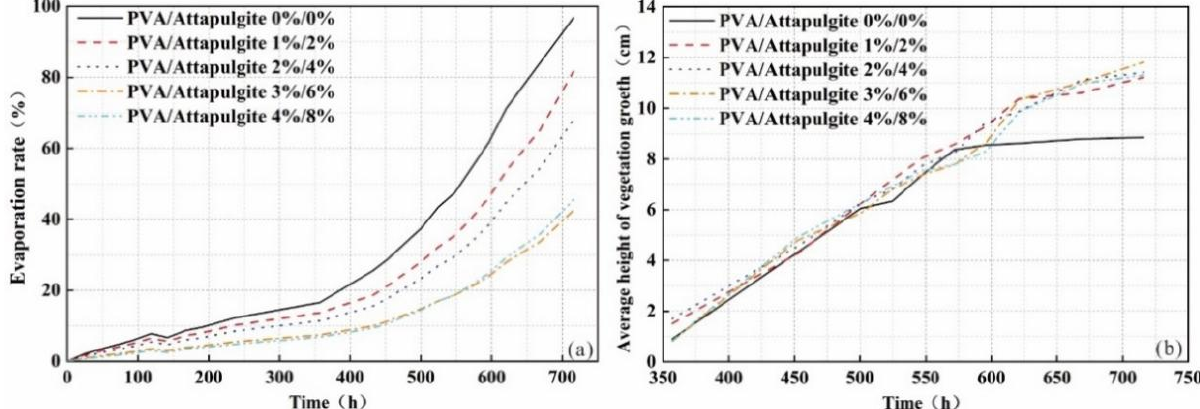
Figure 10. Initial state of the composite sample: ( a ) PVA content: 0%, attapulgite: 0%; ( b ) PVA content: 1%, attapulgite: 2%; ( c ) PVA content: 2%, attapulgite: 4%; ( d ) PVA content: 3%, attapulgite: 6%; ( e ) PVA content: 4%, attapulgite: 8%.